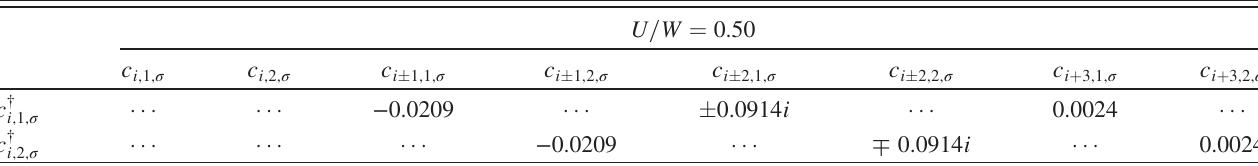
TABLE I. Mean-field renormalization with U=W ¼ 0 . 50 and α ¼ 0 . 45 . The input on ½ c † il σ ; c jl 0 σ (cid:4) represents the renormalized mean- field parameter h c † il σ c jl 0 σ i . The result is homogeneous and spin degenerate; hence, the listed values contain information about all sites and flavors. Note that interactions have generated neither spin nor valley mixing. We have subtracted the bare band contributions = j MF jÞ > 100 . evaluated at ν ¼ 0 . 5 and ignored all mean fields with ðj MF j max